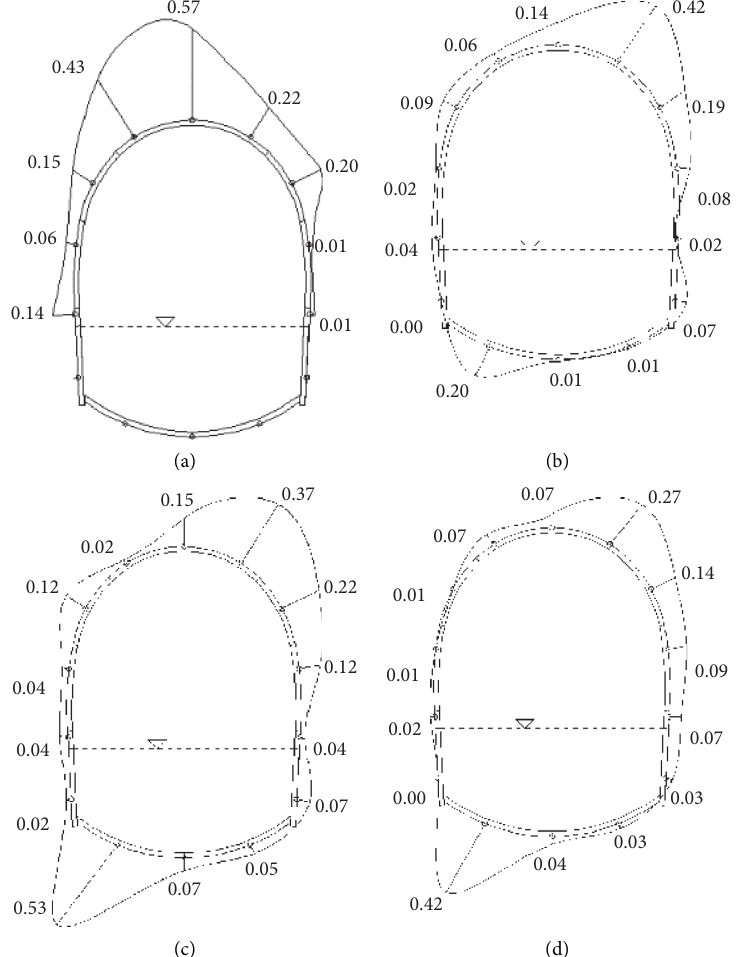
Figure 9: Distribution of surrounding rock pressure on the cross-section A (unit: MPa) (a) 5 days after excavation, (b) after excavation of lower bench and inverted arch, (c) before construction of secondary lining, and (d) after deformation stabilization.